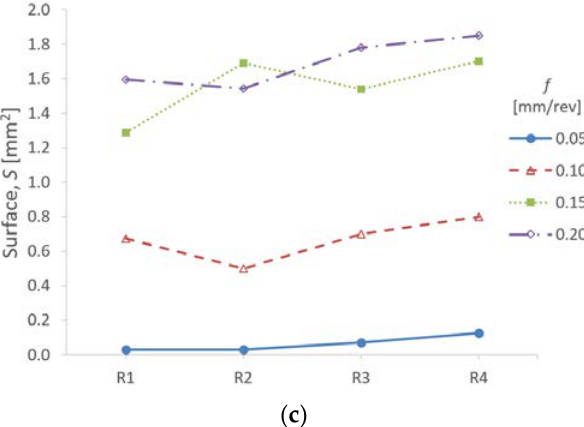
Figure 10. S evolution for each repetition ( Ri ) as a function of f , for: ( a ) v c = 40 m/min; ( b ) v c = 60 m/min; ( c ) v c = 80 m/min.